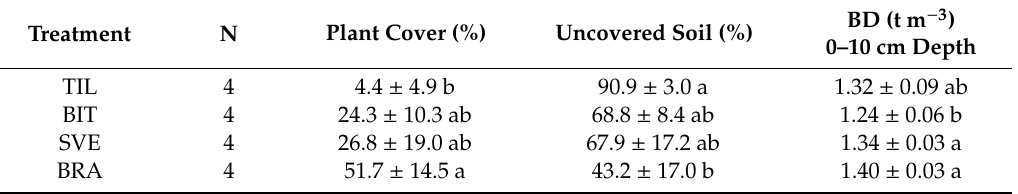
Table 3. Measured field parameters in 2017 for the di ff erent treatments. TIL: conventional tillage; BIT: bitter vetch; SVE: spontaneous vegetation and BRA: Brachypodium distachyon